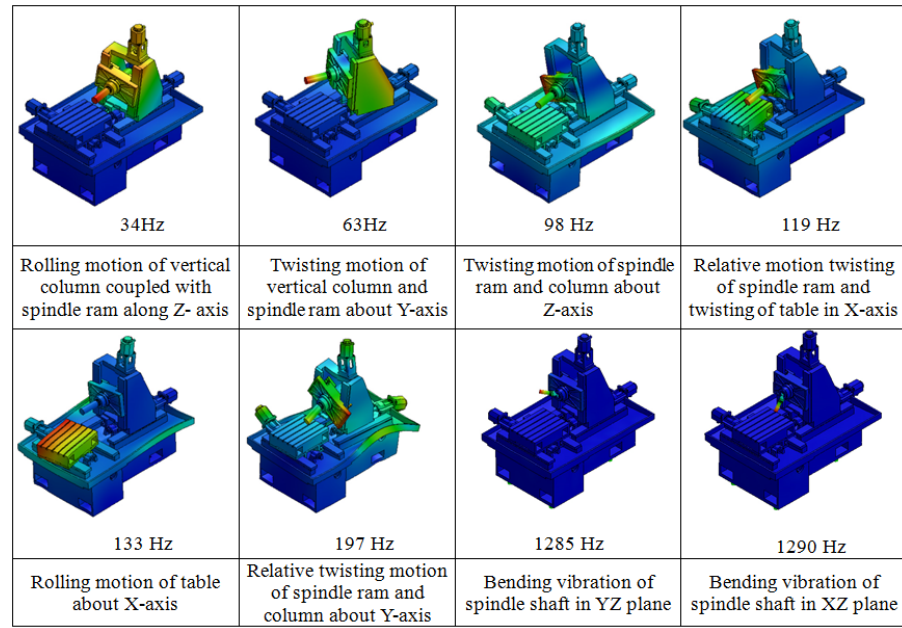
Figure 7. Fundamental vibration modes of the milling machine.